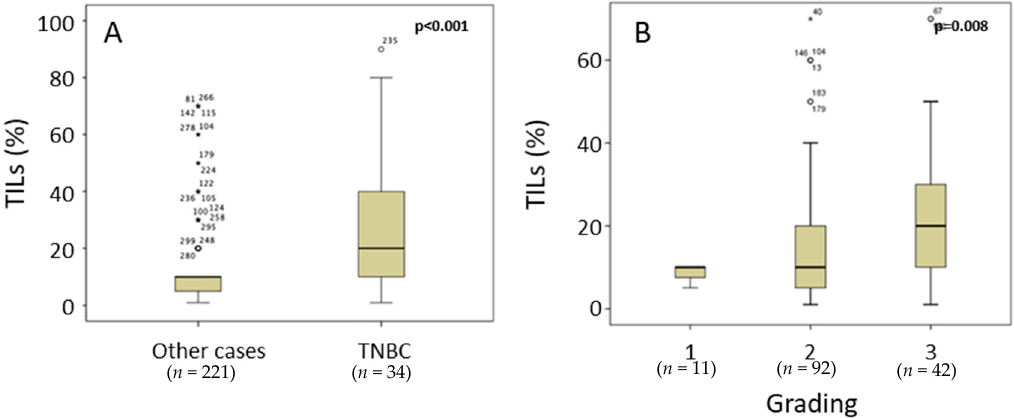
Figure 2. TIL density, according to Salgado, is significantly higher in cases with triple-negative tumors compared with remaining cases (( A ); p < 0.001) and increases significantly from G1 to G3 tumors (( B ), p = 0.008). Mild outliers are marked with a circle (O) on the boxplot. Extreme outliers are marked with an ( ★ ) on the boxplot.